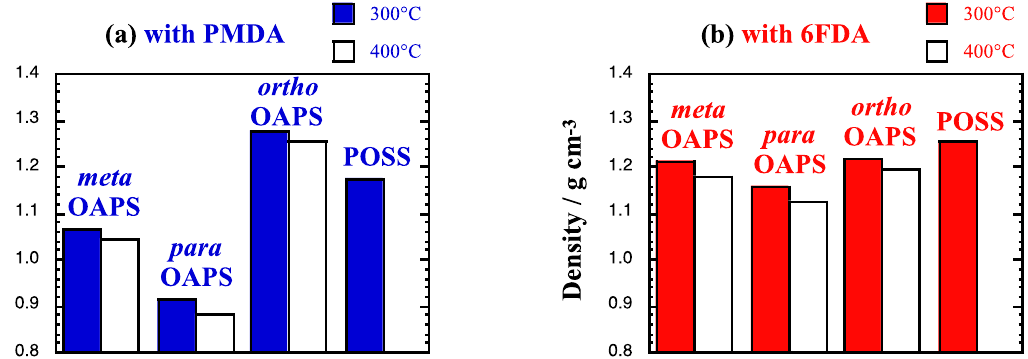
Figure 4. Compared average densities ρ network at 300 ◦ C (colored bars) and 400 ◦ C (white bars) for the pure polyOAPS/POSS-imide networks based on the organic ( a ) PMDA and ( b ) 6FDA imides. The pressure is 1 bar and the maximum standard error is 0.002 g cm −3 .